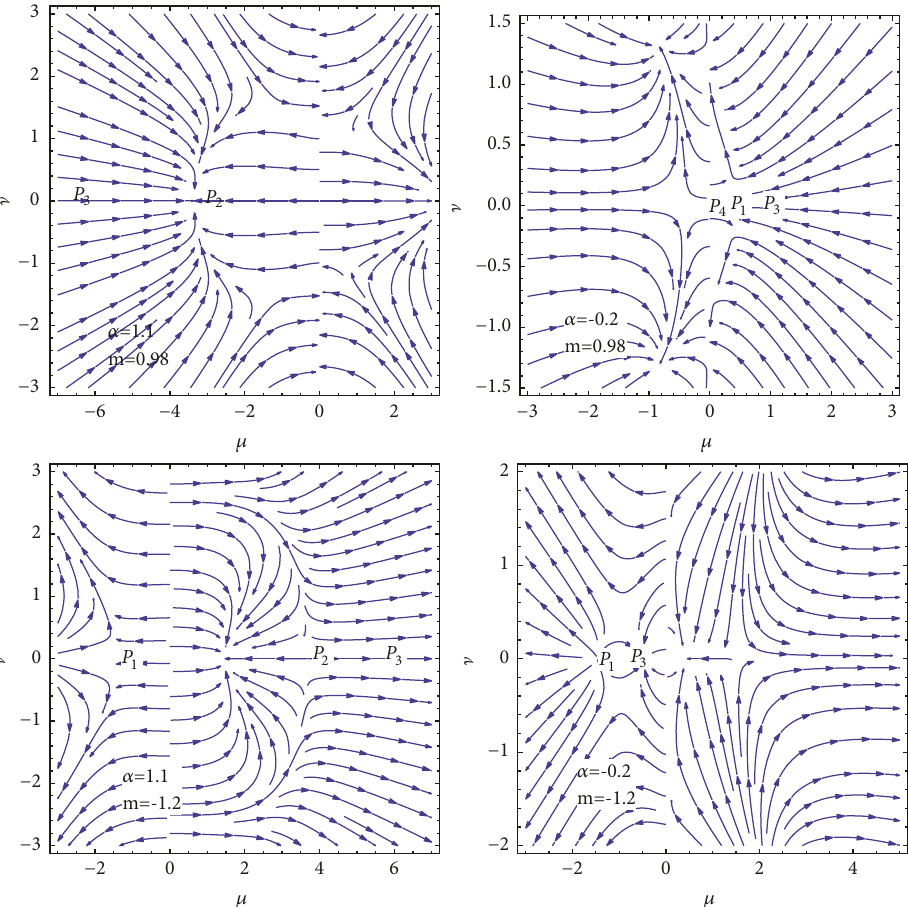
Figure 1: Plots for phantom coupled cosmic model with 𝑄 = 𝛼 ̇𝜎 𝑚 and 𝜆 = 2